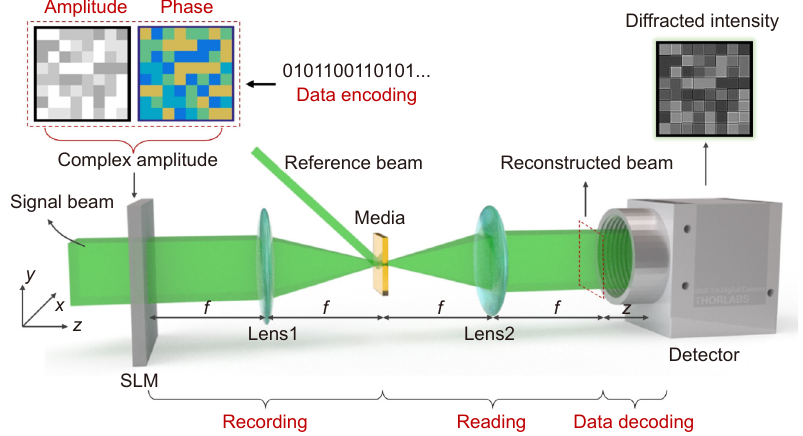
Fig. 1 | Conceptual diagram of HDS with complex-amplitude-modulated data